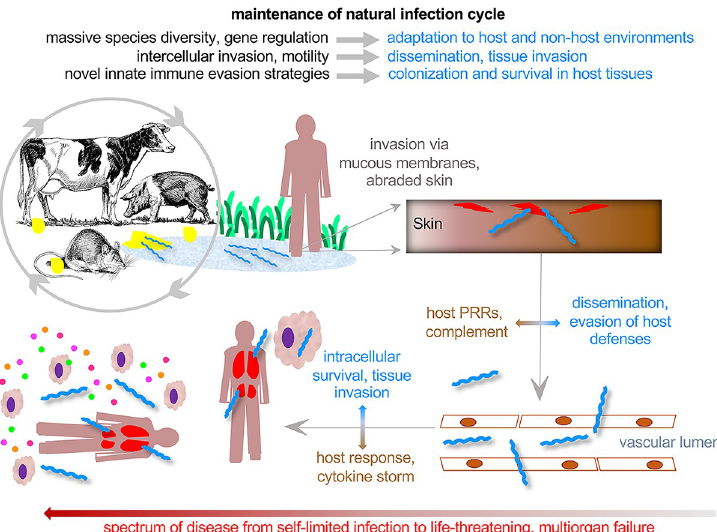
Fig 1. Overview of leptospirosis. Potentially human pathogenic leptospires are maintained in zoonotic infection cycles in wildlife and domestic animals. Leptospires colonize the renal proximal tubule of reservoir hosts and are shed in the urine. Urine contamination of water and mud are common sources of human exposure. In humans and disease susceptible animals, leptospires disseminate and cause symptomatic disease ranging from mild to severe and, in some cases,